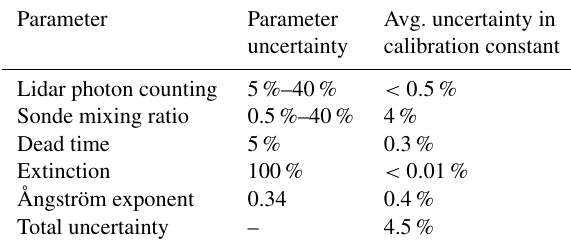
Table 2. Components of the calibration uncertainty, their inherent uncertainty, and their contribution to the uncertainty of the calibra- tion constant for both the trajectory and traditional methods. The uncertainty contributions are the same for both methods since the only difference between the two methods is the selection of lidar